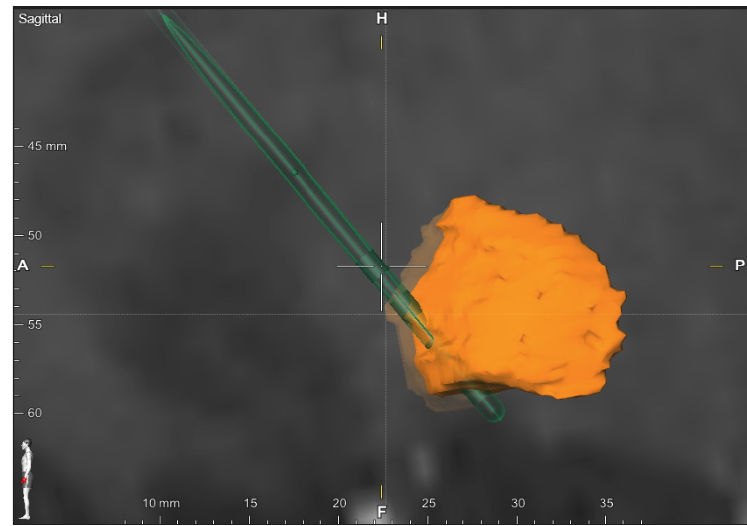
Figure 2. Review of the DBS-target. Sagittal view of a Gpi electrode crossing the Gpi. Patient was stimulated on the most distal contact point. Coordinates relative to anterior commissure: 18.3 mm lateral, 6.5 mm posterior, and 6.0 mm inferior. Stimulation settings: 2.4 Volt, frequency 130Hertz, pulse width 60 microseconds (A: anterior, P: posterior). Table 2. Baseline clinical characteristics of the study